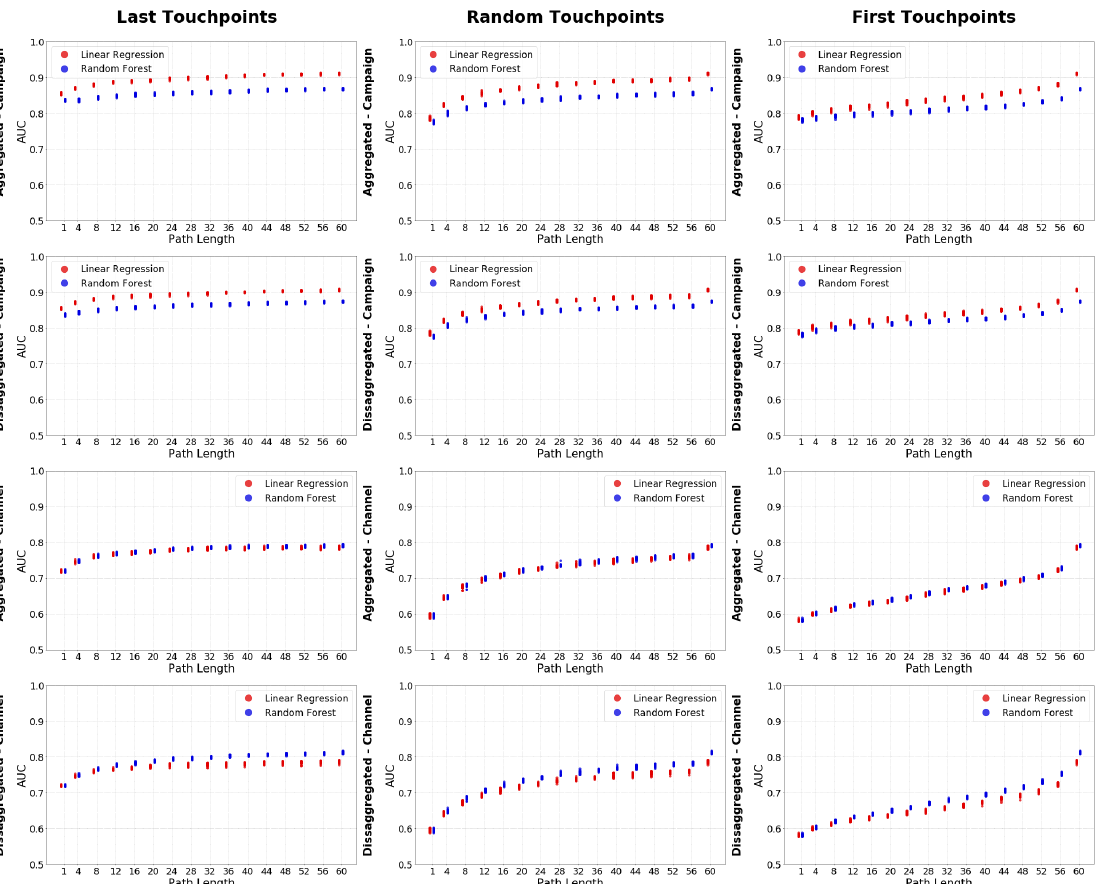
Figure 4. Area under the curve for random forest and linear regression in all the use